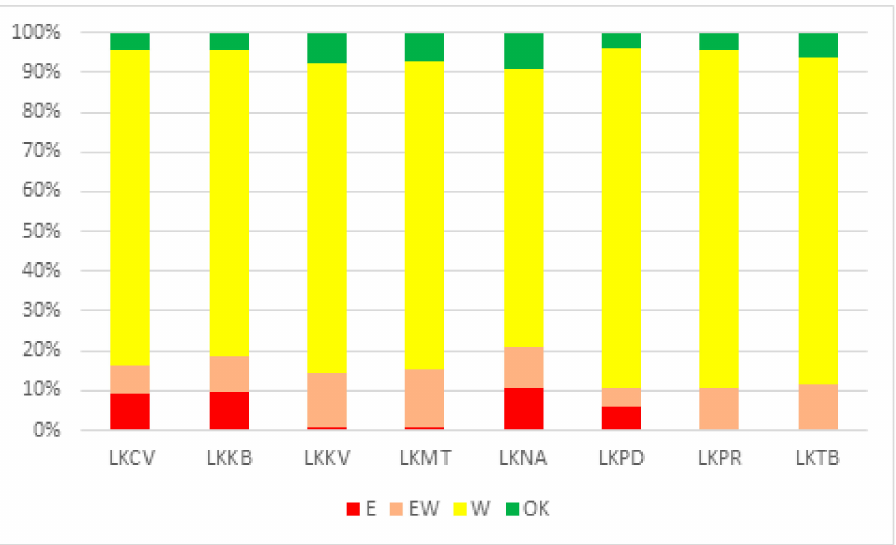
Figure 3. Evaluation of the formal error rate of TAFs by individual station (see the text for